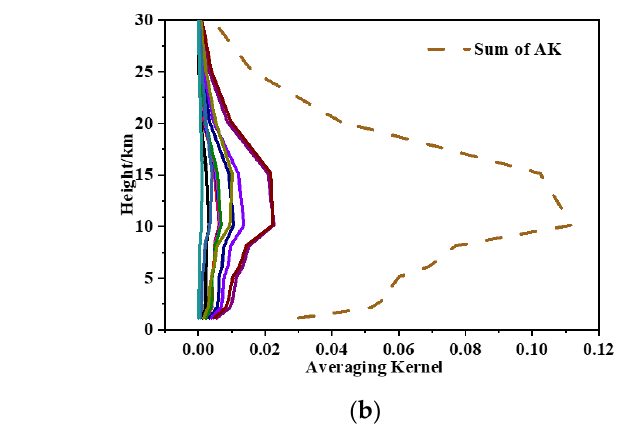
Figure 14. Averaging Kernel of ( a ) HDO and ( b ) CH 4 .